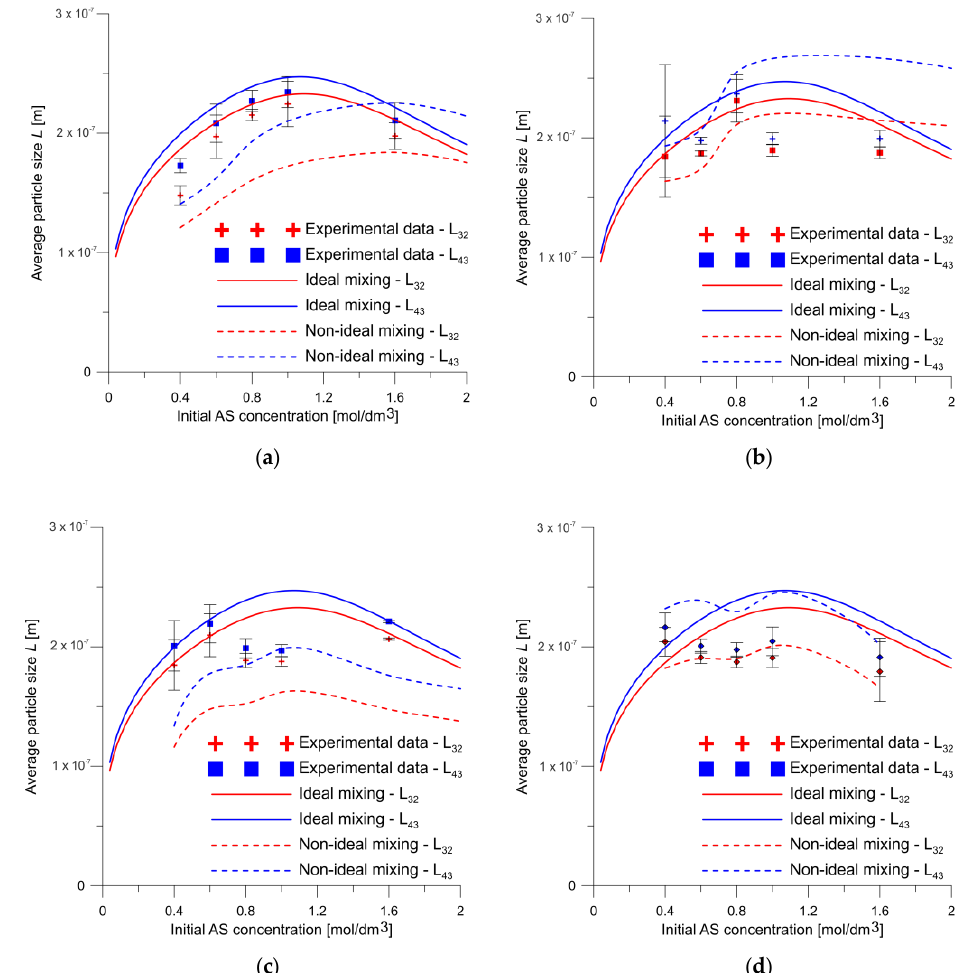
Figure 13. Characteristic particle sizes for V-type reactor at ( a ) 20 and ( b ) 50 mL/min flow rates and for T-type reactor at ( c ) 20 and ( d ) 50 mL/min flow rates (ideal mixing refers to the simulation of a tubular reactor with ideal mixing conditions, and non-ideal mixing refers to CFD modelling that takes into account the reactor geometry and flow conditions).